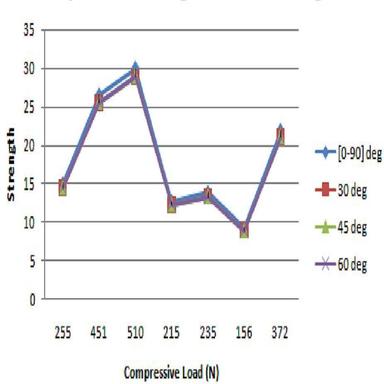
Compressive Strength of C–C laminate for various fiber angles.